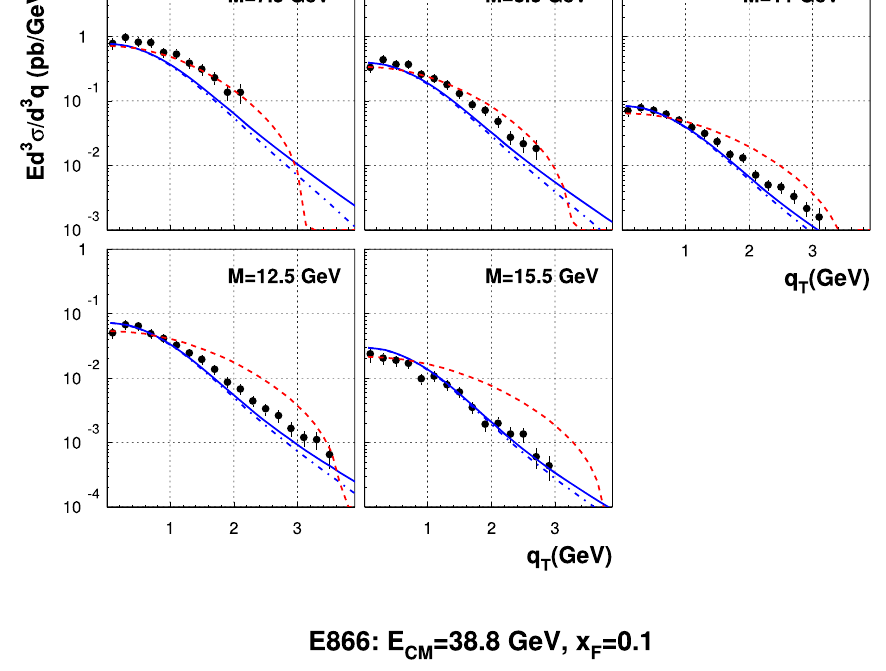
Fig. 6 Transverse momentum dependence of DY cross-section: data from fixed target experiments E605 [39] (upper panels) and E866 [41] (lower panels) are compared with on-shell CCFM-K (blue solid), off-shell CCFM-K (blue dash-dotted) and CSS (red dashed)